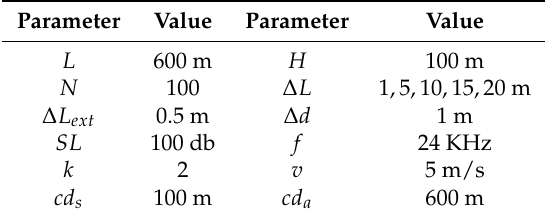
Table 2. Parameters used in the simulation.